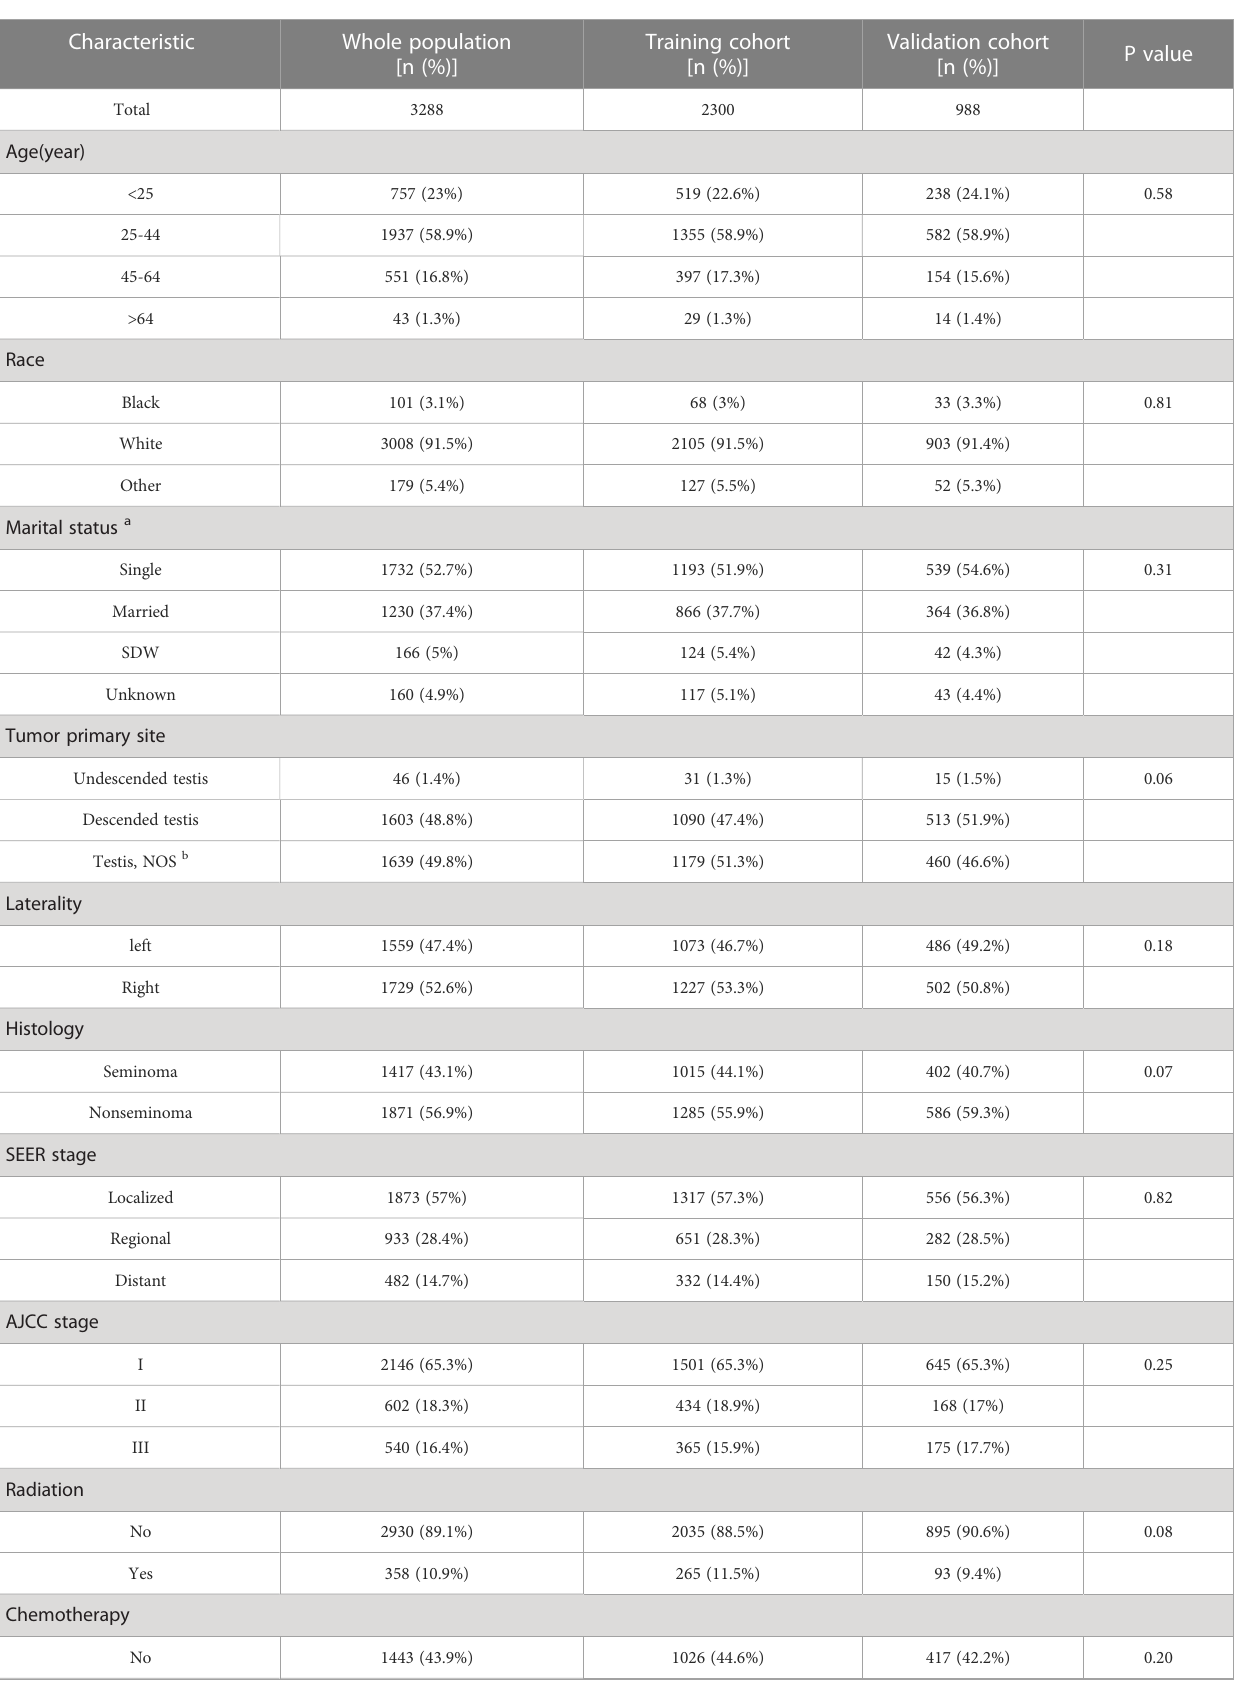
TABLE 1 Baseline characteristics for 3288 patients of testicular germ cell tumors with lymphovascular invasion (TGCT-LVI).